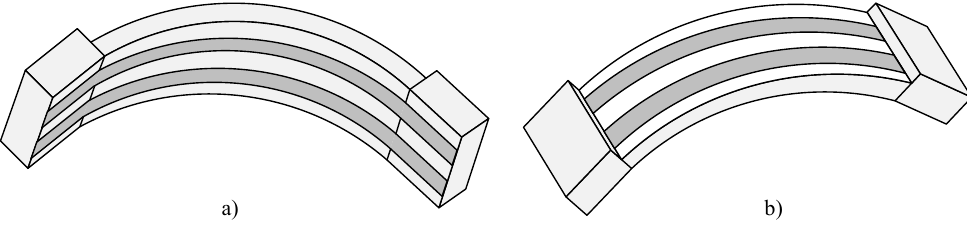
Figure 29. Strengthened arch at: ( a ) intrados; ( b ) extrados [127].